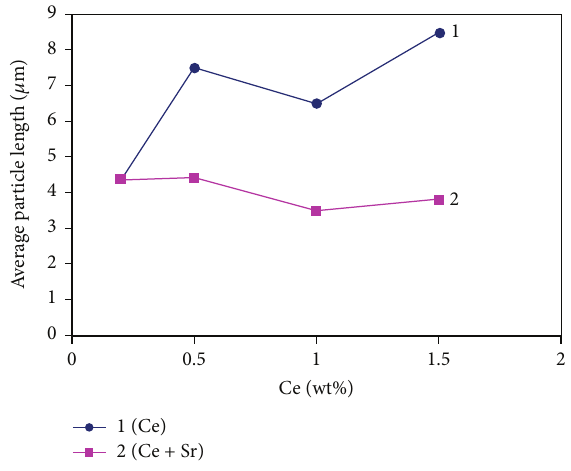
Figure 16: Effect of Ce and Ce + Sr additions on the average Si particle length in 356 alloy.